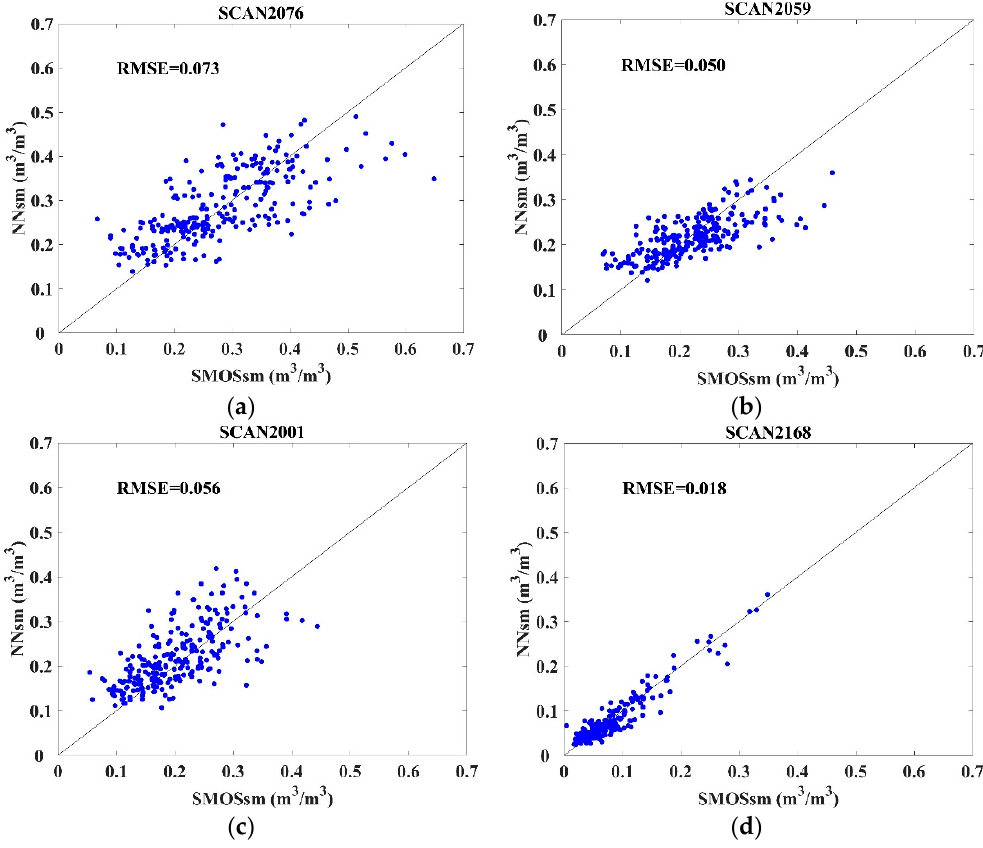
Figure 5. Scatterplots for trained NNsm ( y axis) vs. SMOSL3sm ( x axis) over the training period (July 2010–June 2011, and 2013): ( a ) 2076; ( b ) 2059; ( c ) 2001; and ( d ) 2168. Table 2. Statistical comparison between NNsm and SMOSL3sm for training period (July 2010–June 2011, and 2013). All of these correlations are significant correlations ( p -value < 0.05).